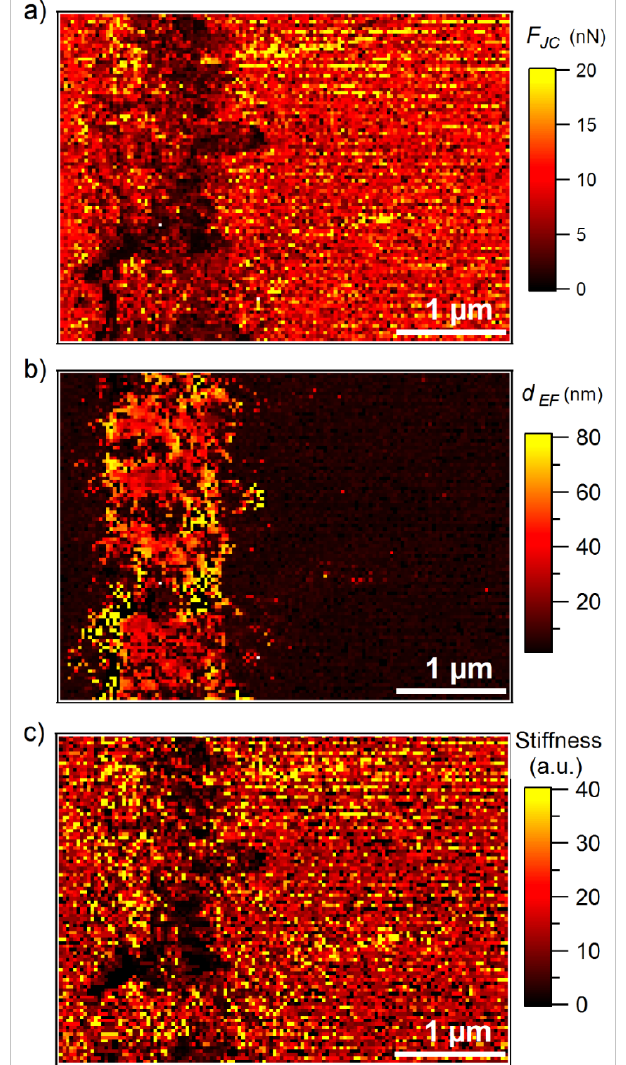
Figure 4. Maps of ( a ) attractive force (jump-to-contact height), ( b ) attractive force (electrostatic force), and ( c ) sti ff ness of the cross-section of EP1(left) / HydBo / EP2 (right) model Figure 4. Maps of a ) attractive force (jump-to-contact height), b ) attractive force (electrostatic force), and c ) stiffness of the cross-section of EP1(left)/HydBo/EP2 (right) model sample.